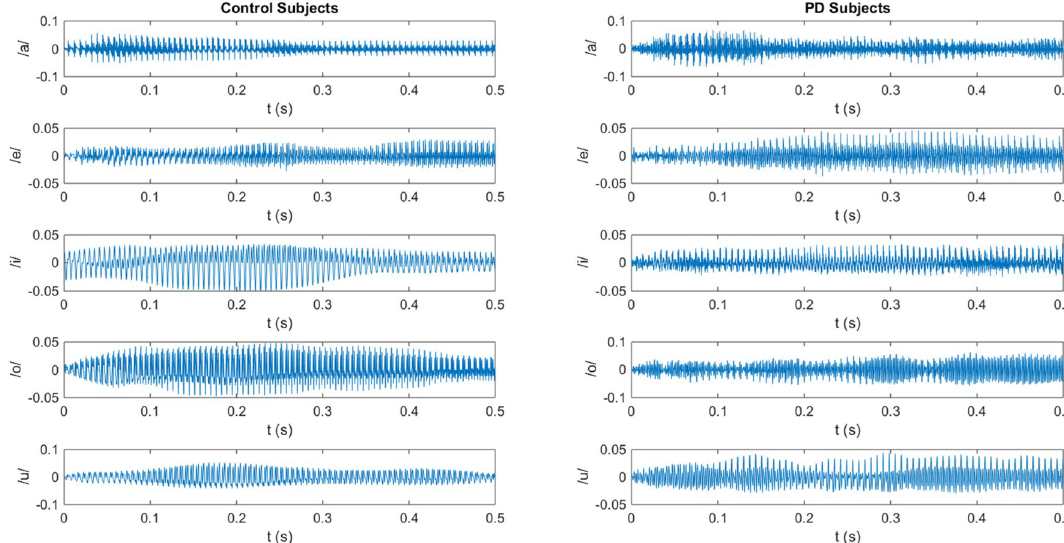
Figure 1. The waveforms of the five vowels recorded from the control subjects and the PD subjects.